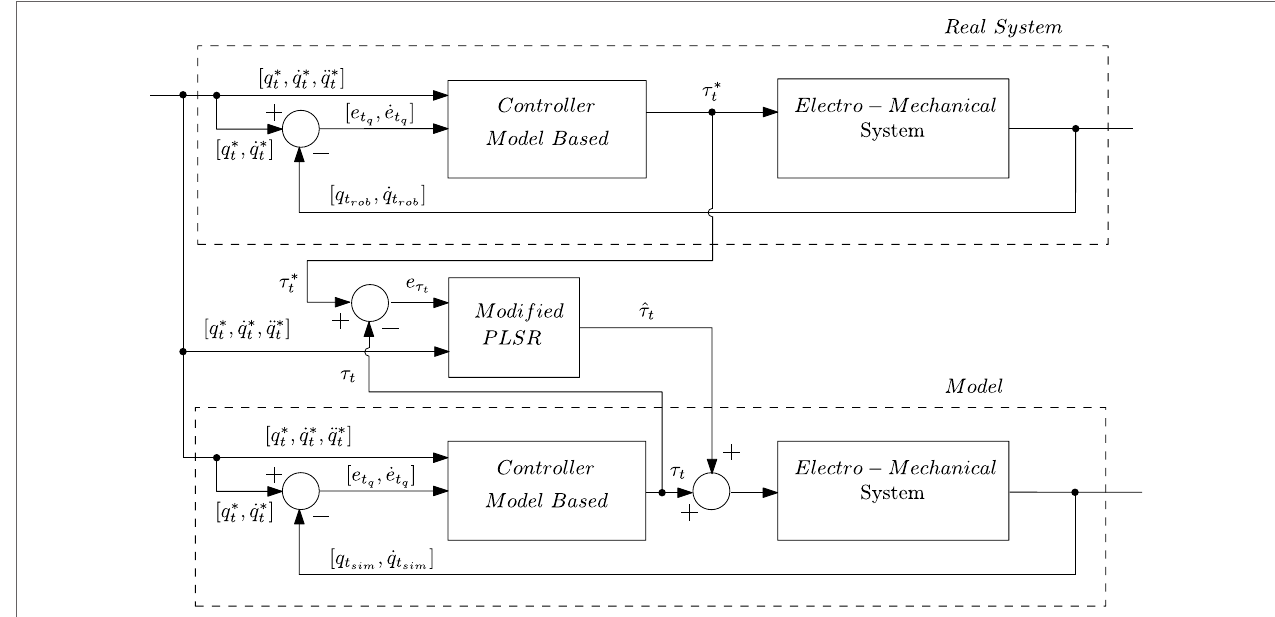
FIGURE 13 | Detailed PLSR modifications: